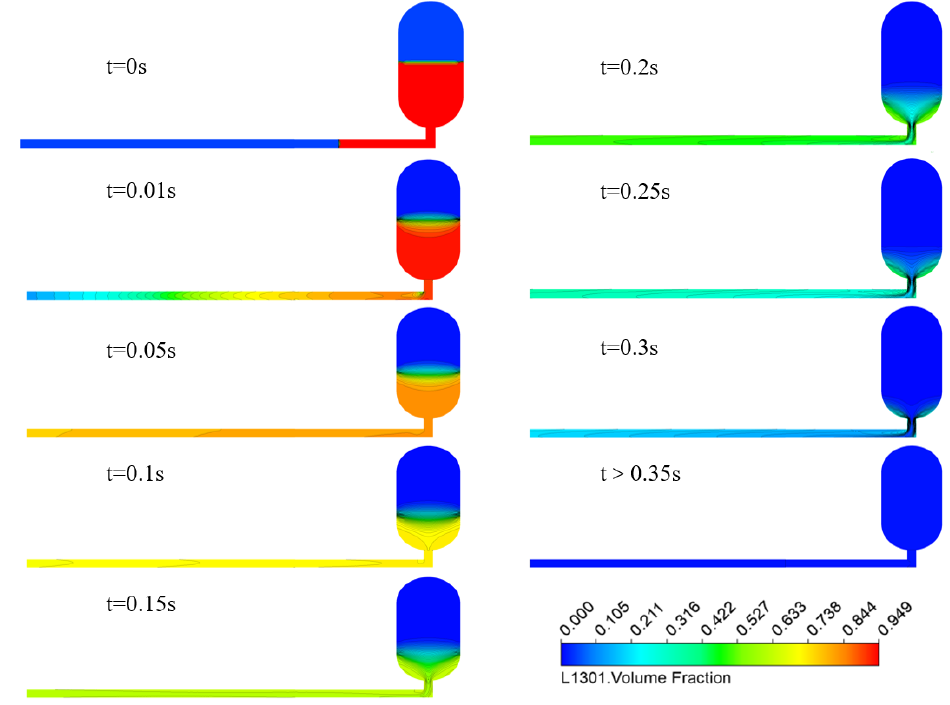
Figure 7. Volume fraction distribution of the liquid 1301 agent at different moments.